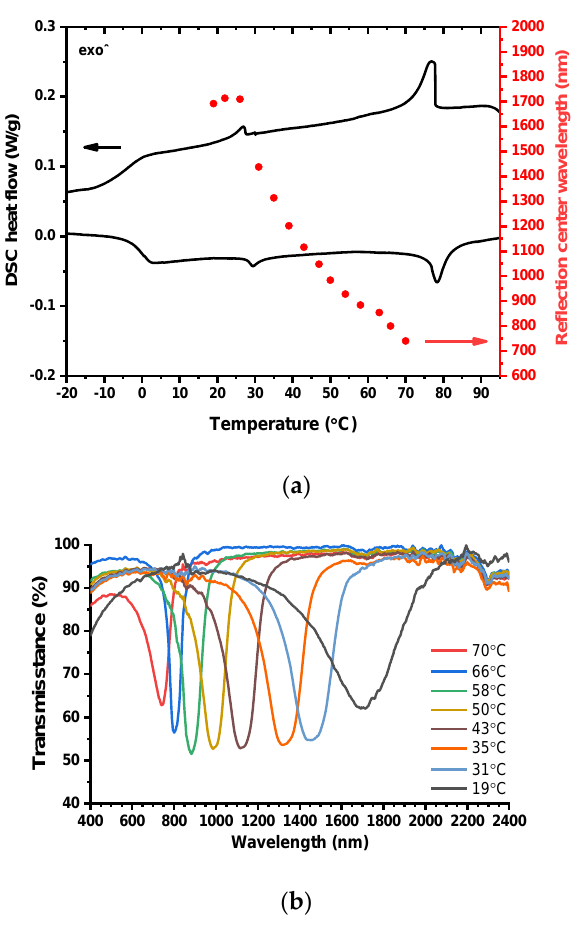
Figure 3. ( a ) Different scanning calorimetry (DSC) curves of TP (black lines), and center of the reflection band as a function of temperature (red dots). ( b ) Transmission spectra of the TP when filled in an alignment cell.